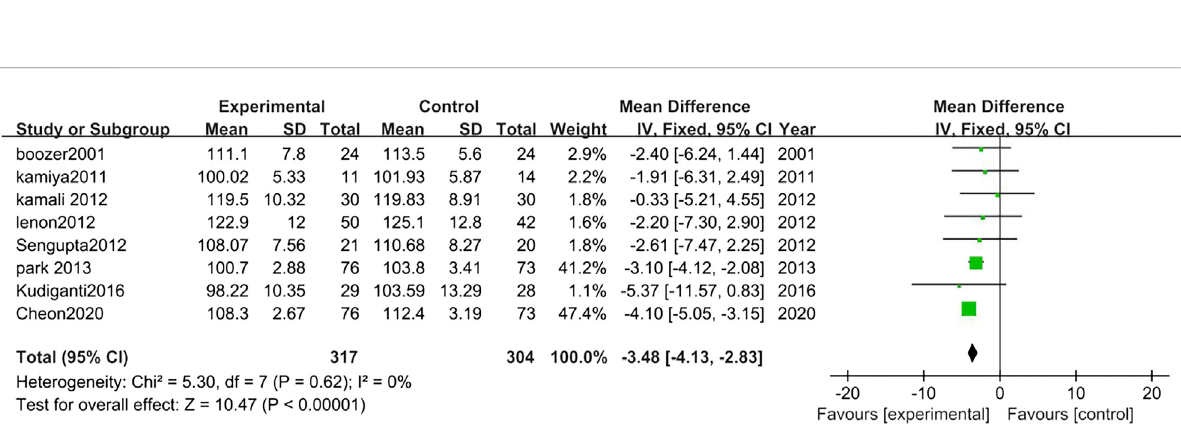
FIGURE 6 Forest plot of hip circumference. Comparison: TCM treatment vs. placeo or blank control.